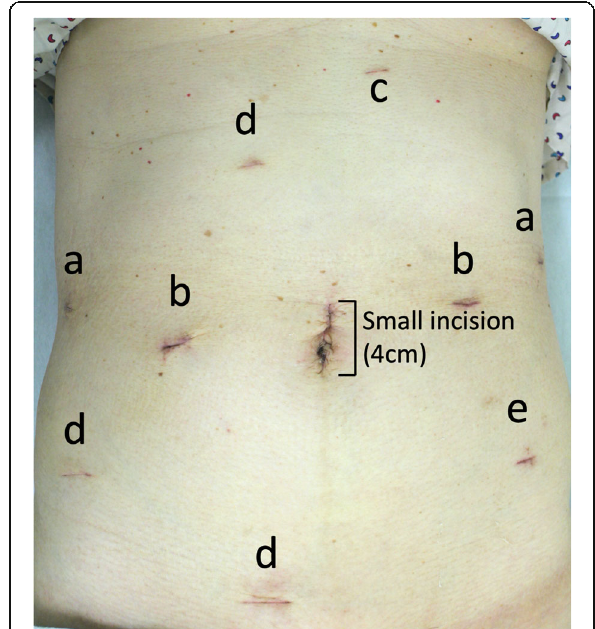
Fig. 4 Abdominal surgical wounds on postoperative day 26. The camera port was placed using the umbilical approach. Ports (a) and (b) Port setting for robotic gastrectomy. Port (c). Wound inserted with a device for lifting the liver. Ports (b) and (d) Port setting for robotic low anterior resection. Port (e) Wound inserted with a drain for colorectal